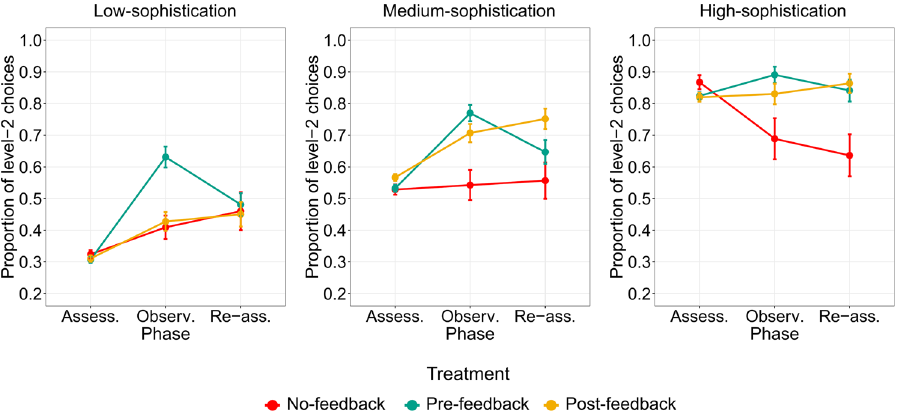
Figure 2. Strategic sophistication across clusters, phases and treatments. Participants were clustered in three groups through a mixture models cluster analysis on the proportion of level-2 choices in the Assessment phase (Low-sophistication, Medium-sophistication and High-sophistication). For each cluster, we plot the proportion of level-2 choices by phase Assessment, Observation and Re-assessment) and treatment (No-feedback, Pre- feedback, Post-feedback). Error bars represent standard errors. In the Medium-sophistication cluster, we show an effect of social learning (Re-assessment–Assessment) in the Post-feedback treatment but not in the Pre- feedback